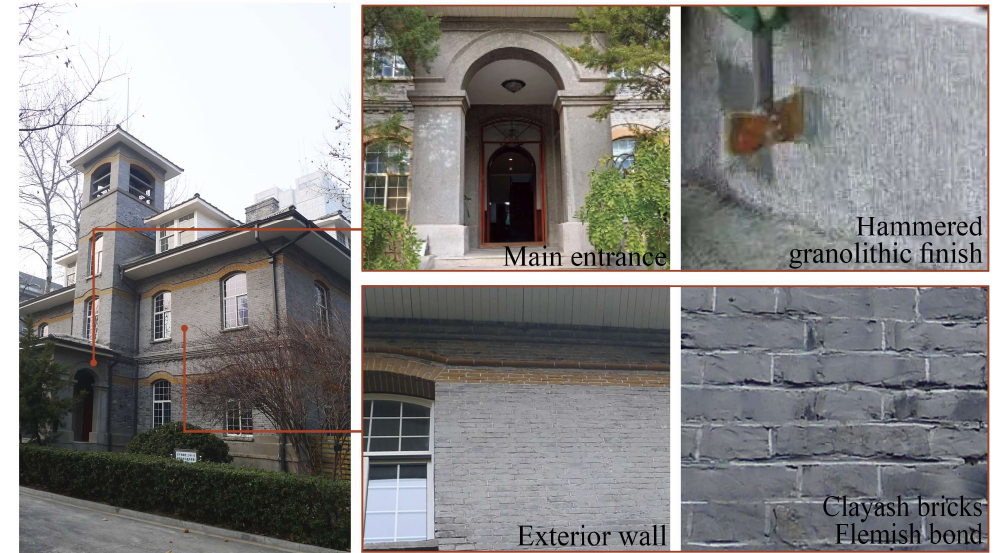
Figure 12. Materials and construction technology (source: author).